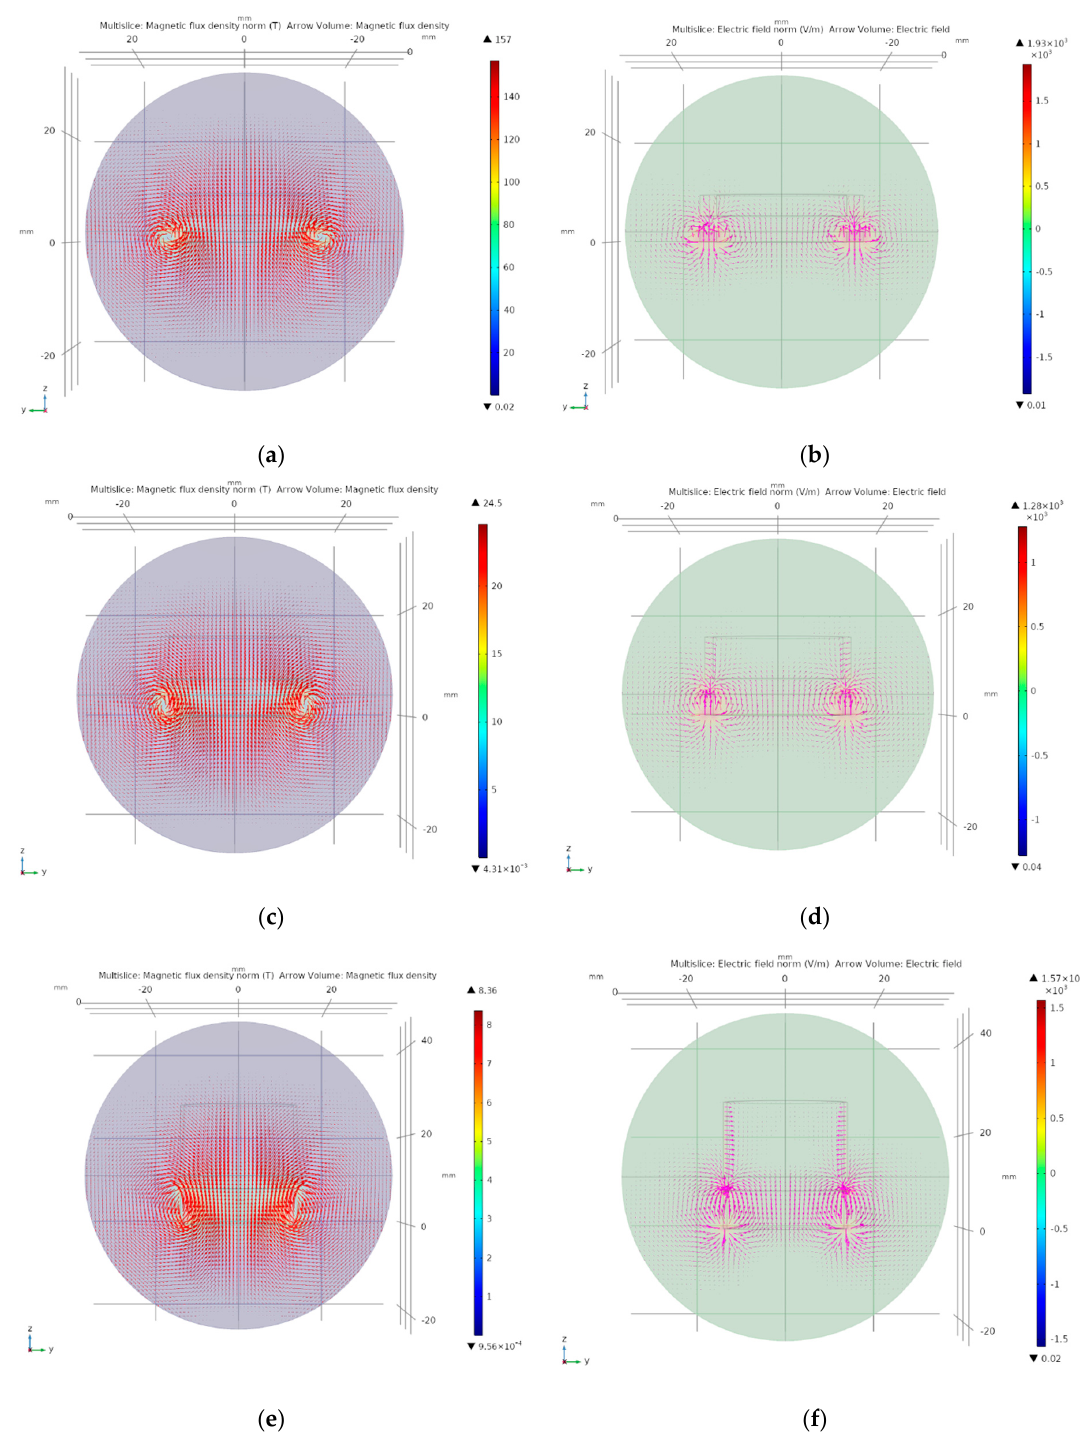
Figure 3. Simulations of the prototypes. ( a ) Magnetic flux density of P1 with 20 g/L of organic fertilizer (OF) sample. ( b ) Electric field of P1 with 20 g/L of OF sample. ( c ) Magnetic flux density of P2 with 20 g/L of OF sample. ( d ) Electric field of P2 with 20 g/L of OF sample. ( e ) Magnetic flux density of P3 with 20 g/L of OF sample. ( f ) Electric field of P3 with 20 g/L of OF sample. Figure 3c,d display the magnetic flux density norm and the electric field of P2 using a 20 g/l of OF sample. In this case, the magnetic flux density norm values obtained varied from 5.29 T to 1.43 T